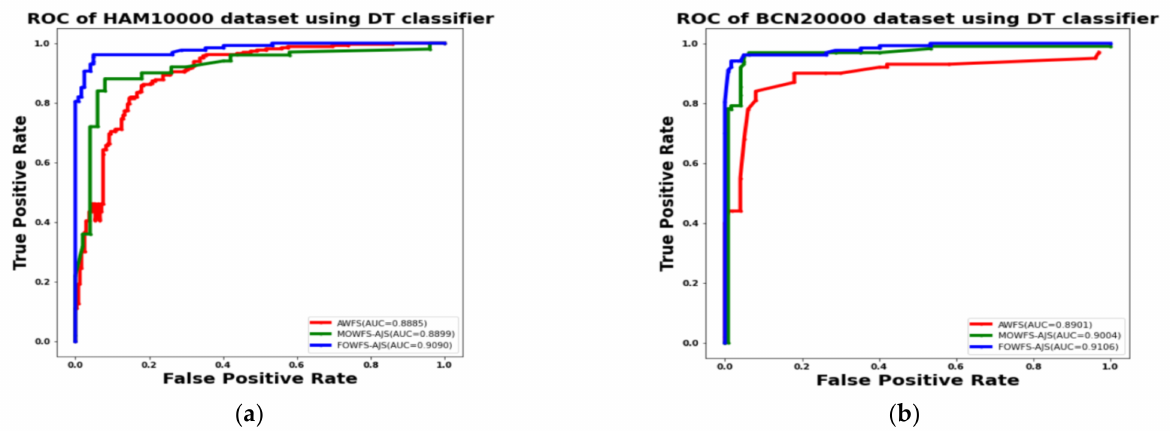
Figure 10. ROC using DT classifier for ( a ) HAM 10000 dataset and ( b ) BCN 20000 dataset.